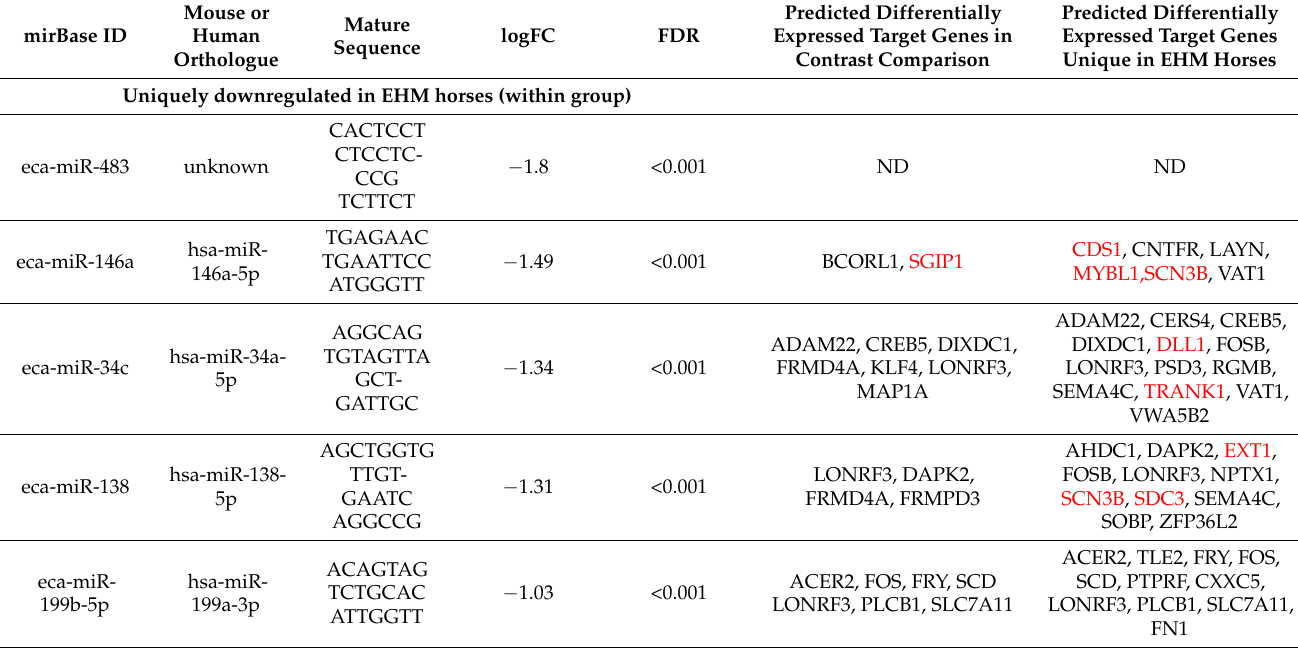
Table 3. Differentially expressed (FDR < 0.05 and log 2-fold change >|1|) miRNAs are shown here. The top lists indicate miRNAs identified in the between group (contrast) comparison. Up-regulated/downregulated terms are those based on the genes upregulated/downregulated in EHM horses compared to Non-EHM horses. The bottom lists indicate the miRNAs uniquely differentially expressed within the EHM group (pre vs. post CH). Upregulated/downregulated refers to genes upregulated/downregulated during viremia compared to pre CH. There were no differentially expressed miRNAs in the non-EHM horses pre vs. post CH. ID numbers next to novel miRNAs indicate the arbitrary ID given to those without corresponding equine, murine, or human IDs. Predicted target genes that were also differentially regulated in the contrast comparison or uniquely regulated in EHM horses are indicated in red when significantly upregulated and in black when significantly downregulated. A summary of predicted target genes of differentially up- and downregulated miRNAs are shown and how they overlap with differentially expressed genes unique to EHM horses in response to EHV-1 CH (within group comparison) and between groups (contrast comparison) are shown in Figure